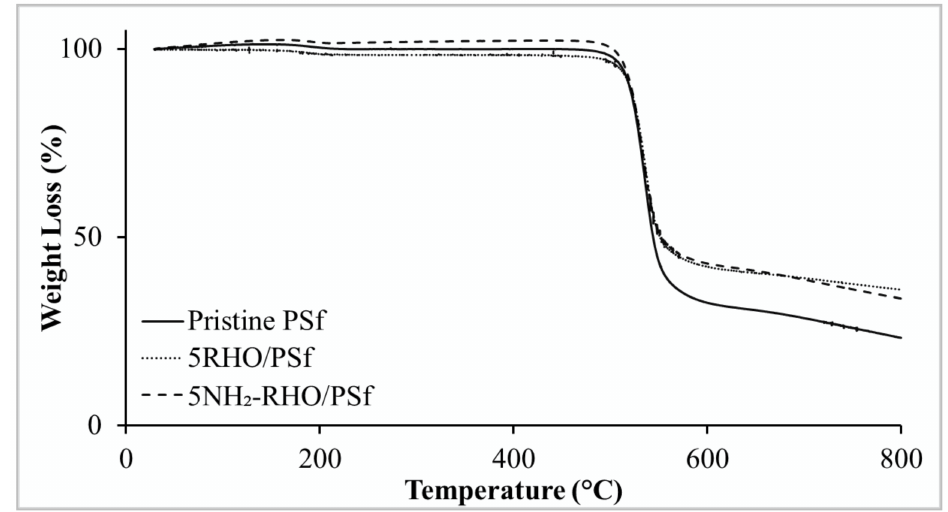
Figure 8. TGA thermograms of pristine PSf membrane, 5RHO/PSf, and 5NH 2 -RHO/PSf